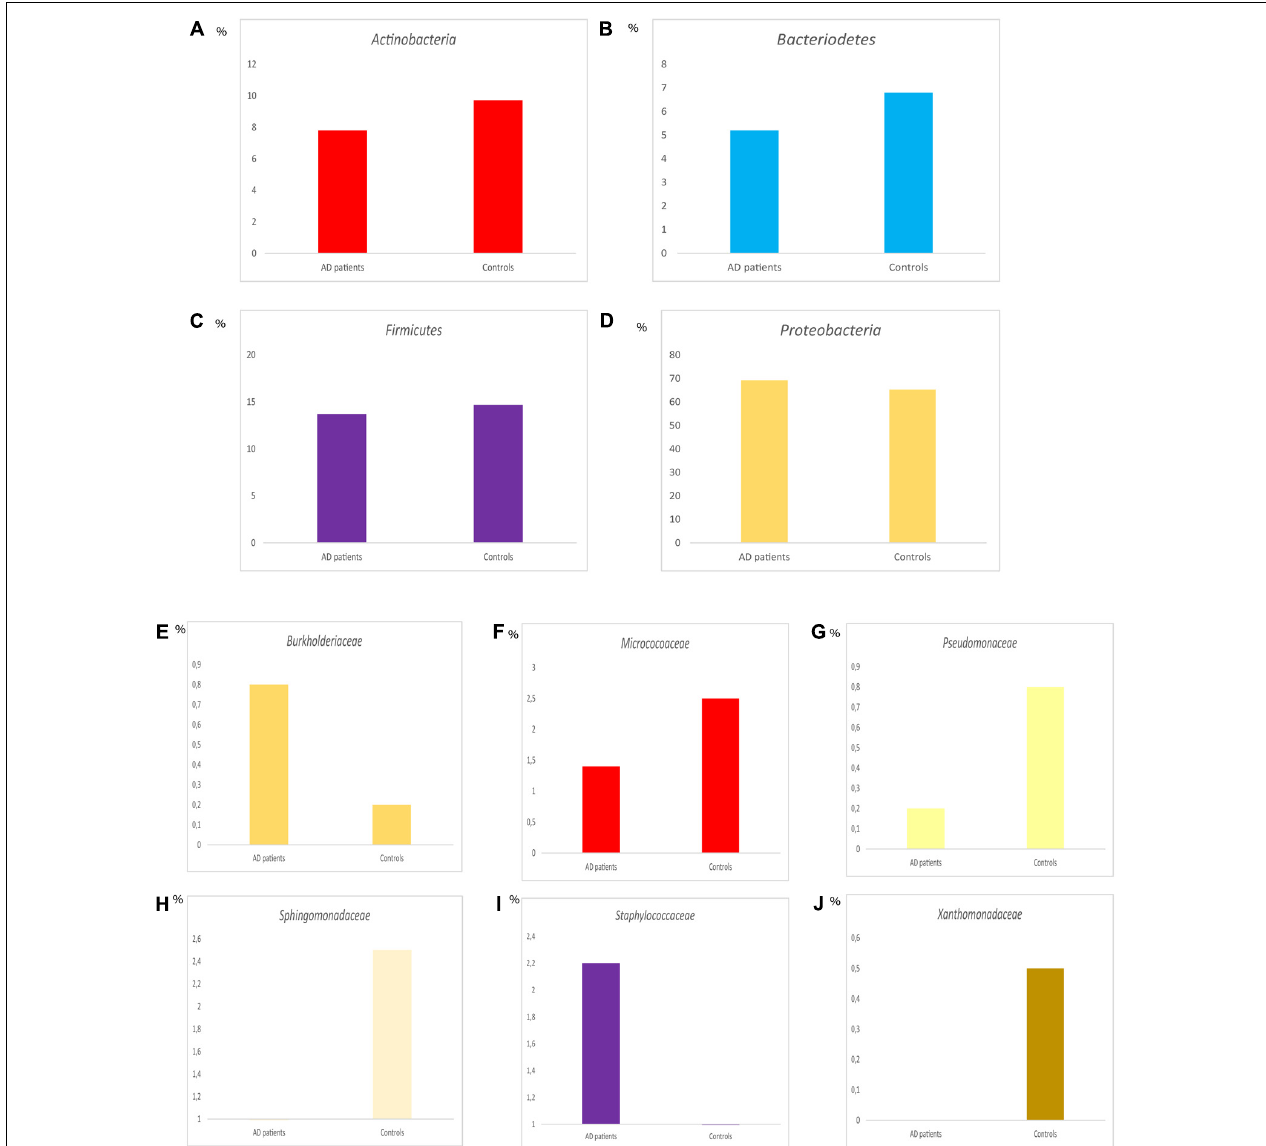
FIGURE 11 | Distribution of bacteria phyla and families between AD patients and controls. Representation of median percentage of the median values of the percentages of different phyla (A–D) . Representation of the median of the percentages of different families (E–J)